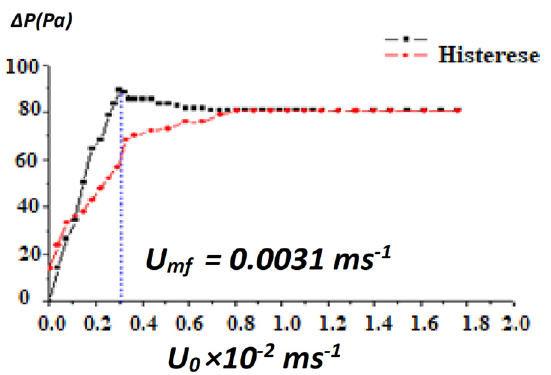
Figure 2. Pressure drop profiles as a function of the surface gas velocity. Conditions: 280.0 g, dp 86 µ m, γ -Al 2 O 3 , 1.0 bar, 973 K.